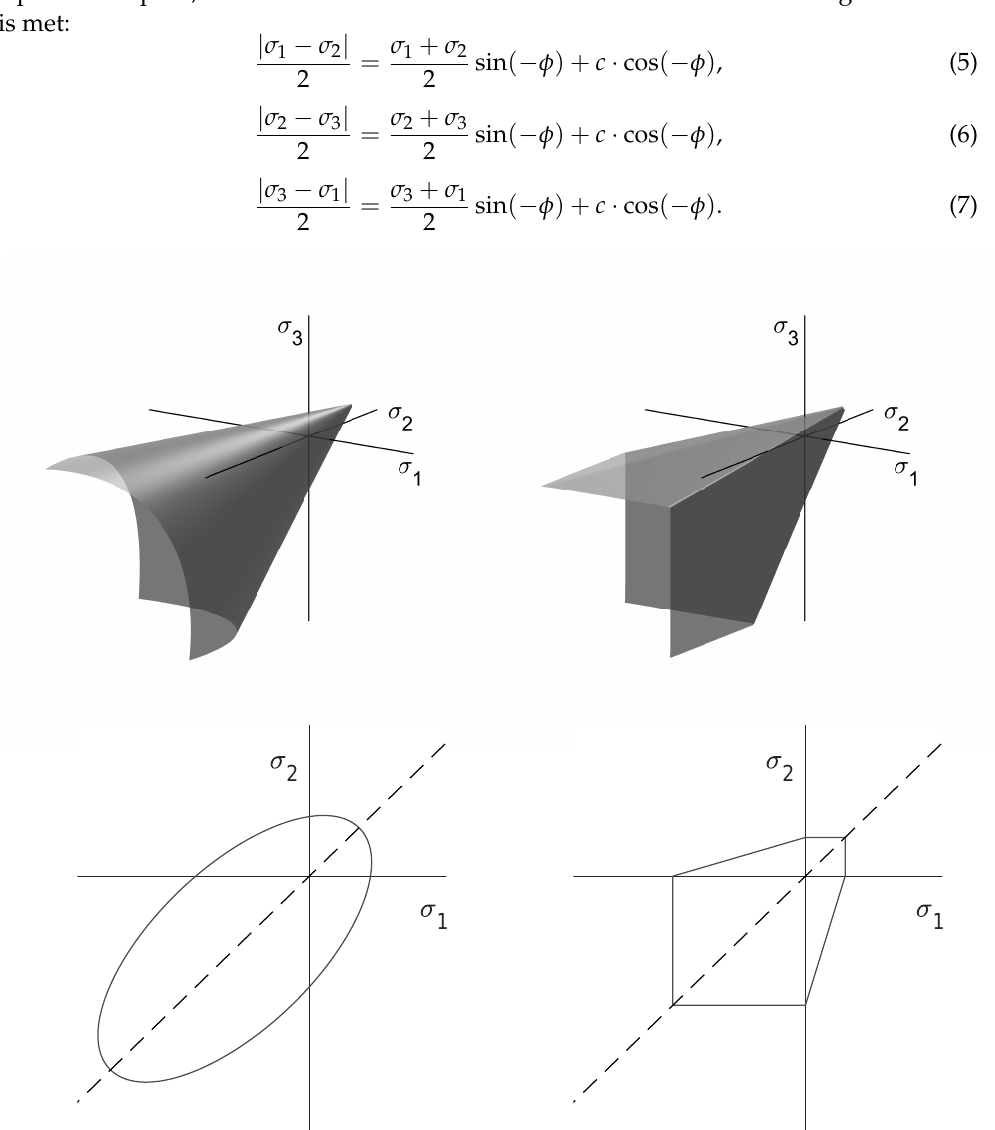
Figure 2. Failure criteria Drucker-Prager ( left ) and Mohr-Coulomb ( right ) in principal stress space. The upper half describes three-dimensional stress states, while the lower half describes plane stress states ( σ 3 =